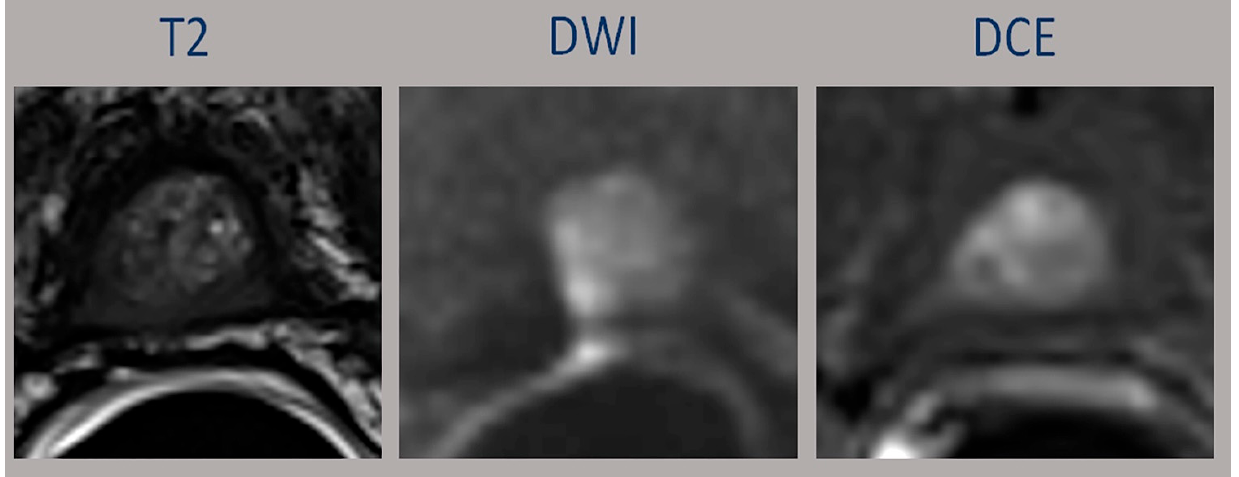
Figure 3. Prostatic adenoma growing in the prostatic bed.